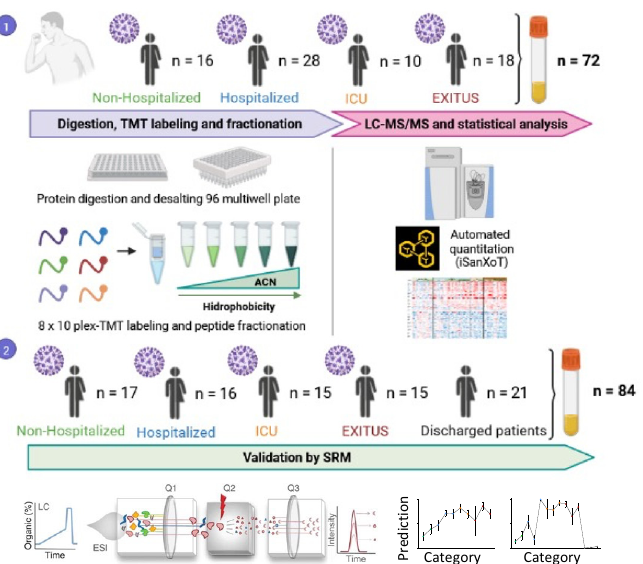
Figure 1. Experimental workflow Seventy-two serum samples (discovery cohort) from patients at different ages suffering from mild to severe COVID-19 were subjected to digestion, TMT-labeling, peptide fractionation, LC-MS/MS and statistical analysis with SanXoT package. To confirm our previous observations 18 proteins were selected for targeted validation by SRM in an independent cohort of 84 patients that included 21 individuals that successfully recovered from SARS-CoV-2 infection.